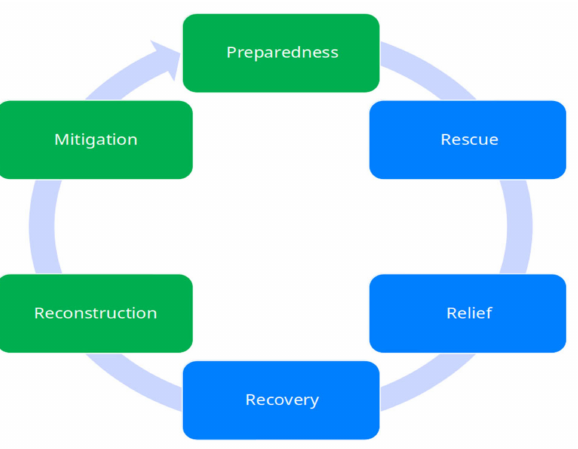
Figure 1. Phases of the disaster management cycle. Green boxes pertain to pre-disaster and intra- disaster phases, while blue boxes are associated with post-disaster phases, the emphasis of this